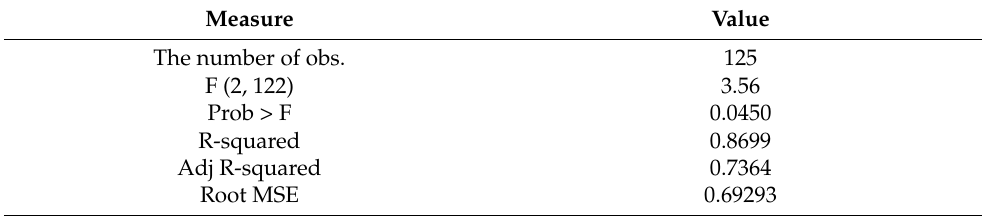
Table 2. Statistical analysis before COVID-19 pandemic. Measure Value The number of obs.